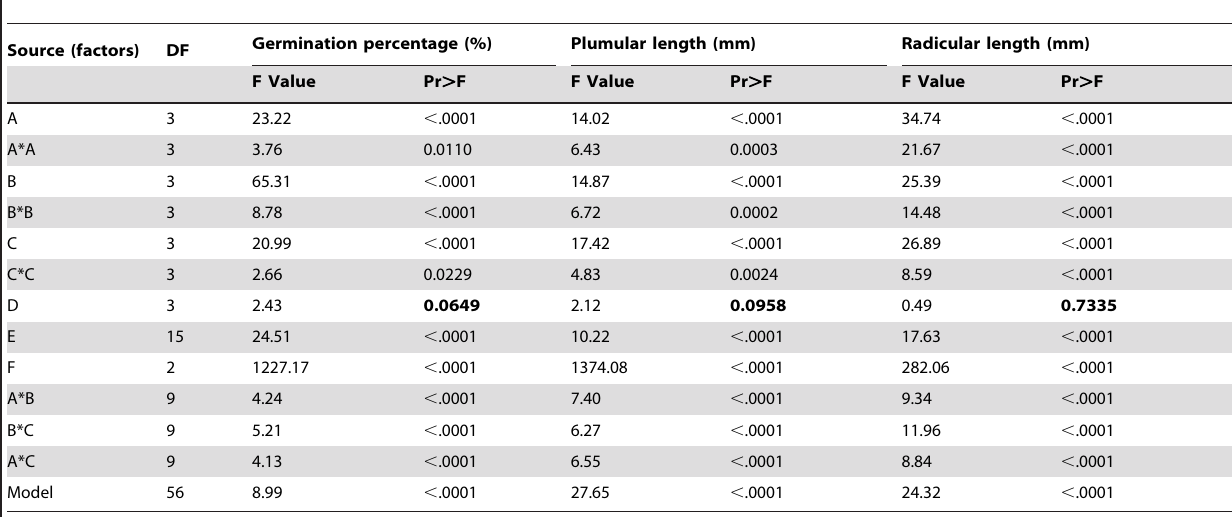
Table 6. Variance analyses for the model, for each experimental factors and among them.